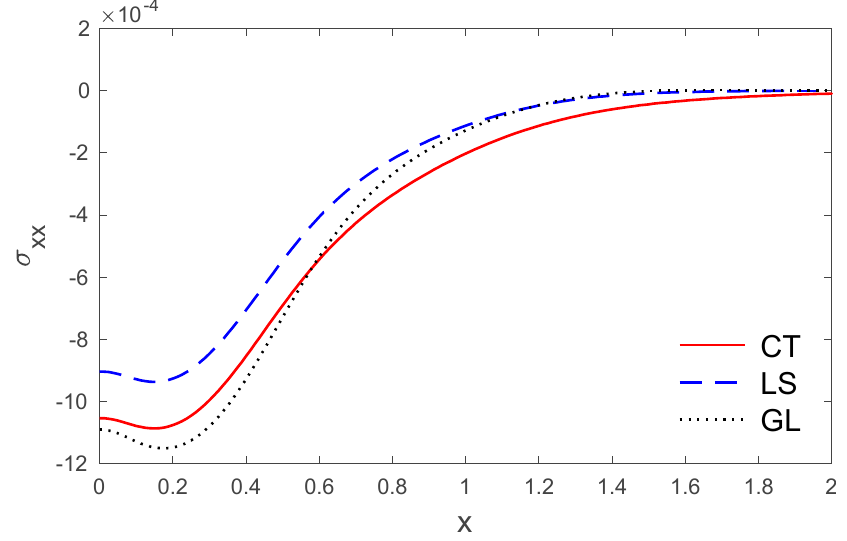
Figure 9. The stress variations 𝜎 (cid:3051)(cid:3051) via 𝑥 with, y = 0.5 under the three models.